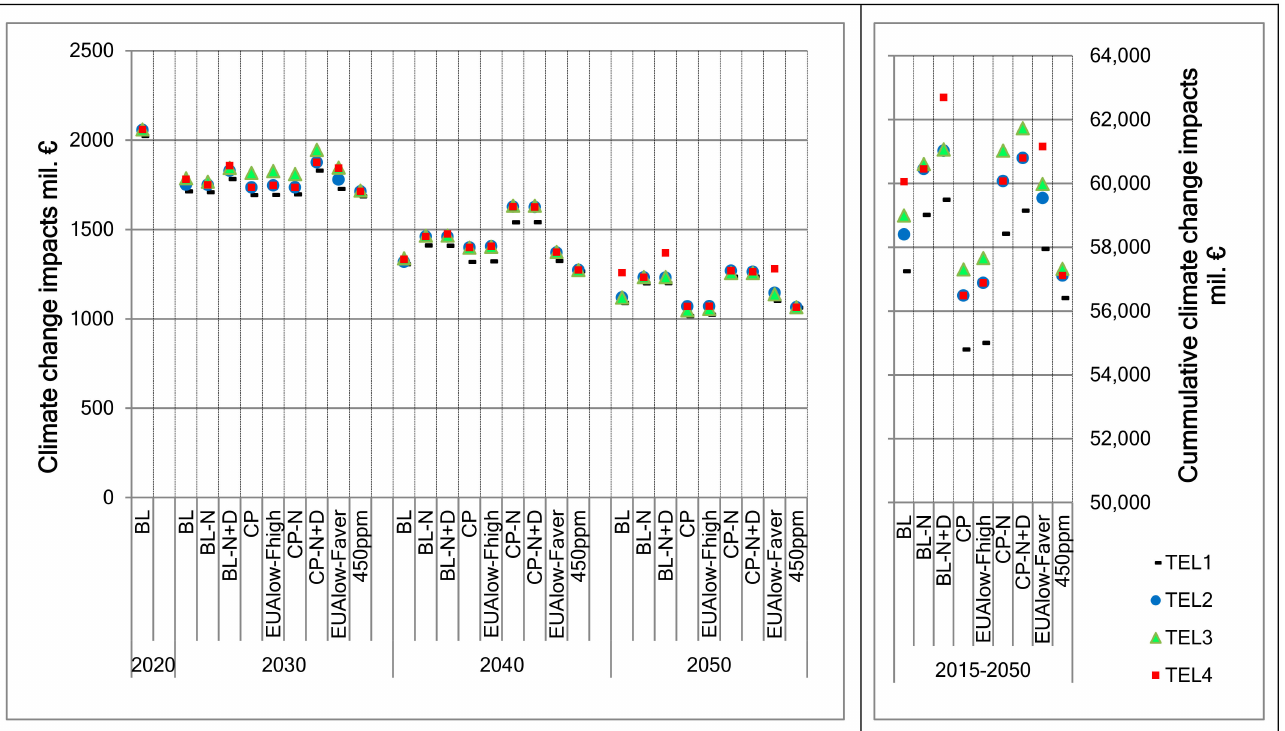
Figure 11. Impacts attributable to GHG emissions and to the whole energy balance, for selected years and cumulative figure. Note: The level of external costs is similar for all assumption sets in 2020. The share of GHG emissions from ETS sectors declines from about 60% in 2020 to a range of 30 and 55% depending on the assumption set. The climate change impacts due to GHGs are actually internalized through the EU